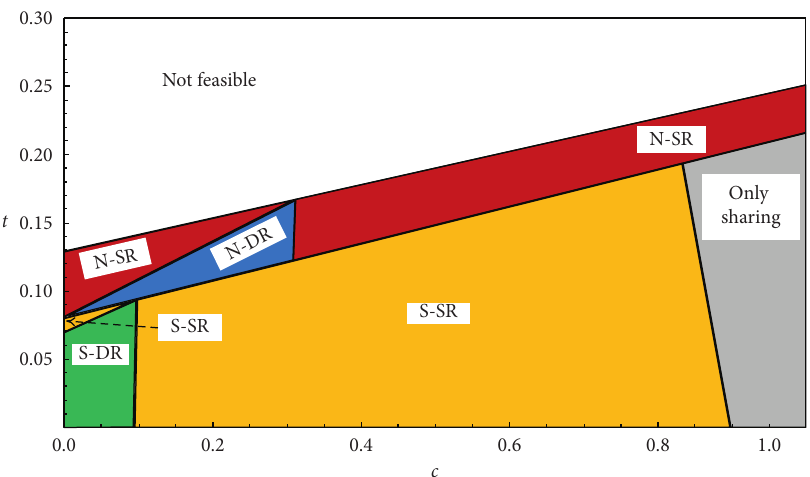
Figure 1: The manufacturer’s optimal business